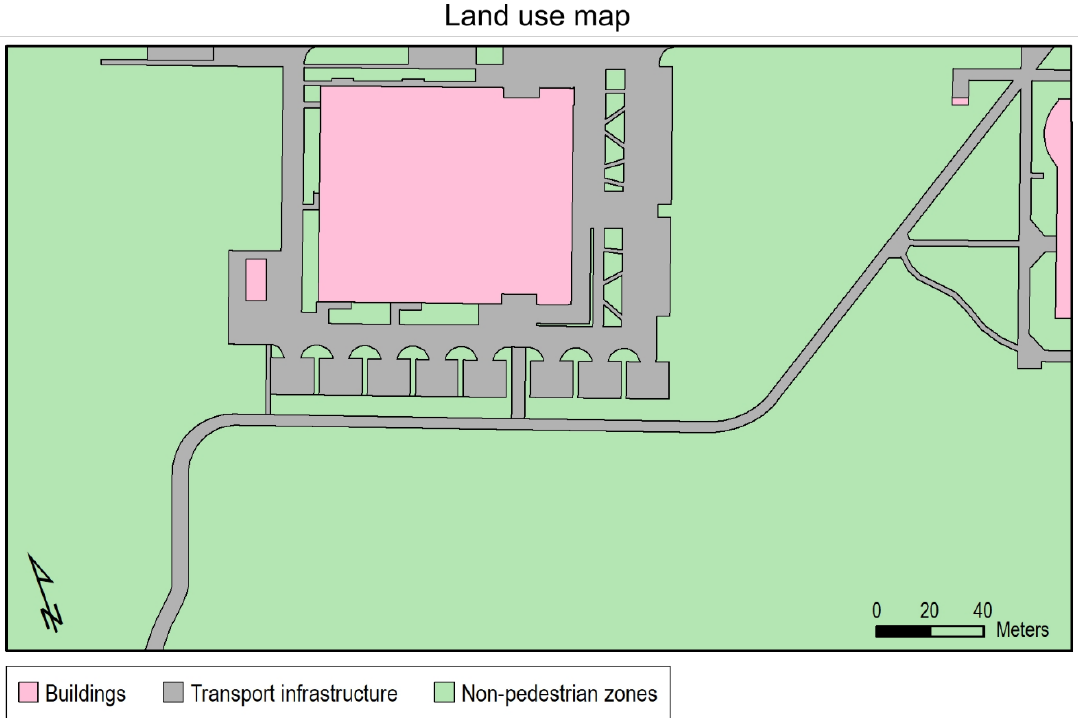
Figure 2. The map of the research area in terms of transport infrastructure: the chorochromatic method (qualitative data).